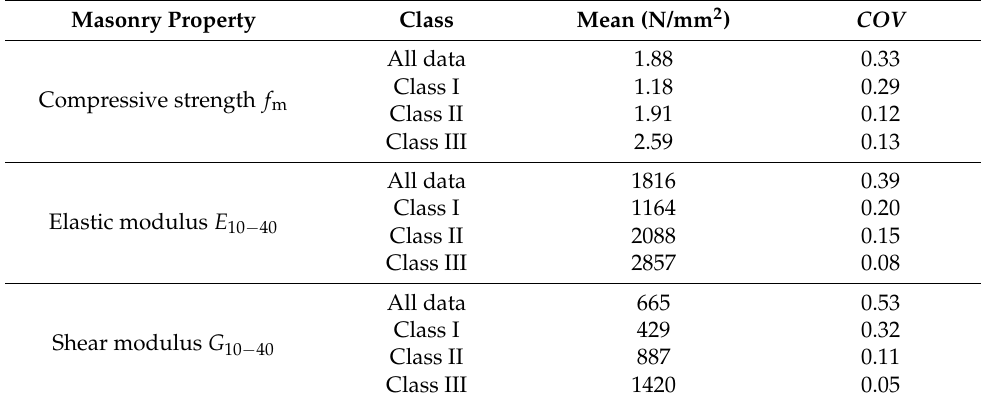
Table 2. Statistical parameters for stone masonry properties based on the collected database and the identified classes (based on data derived from